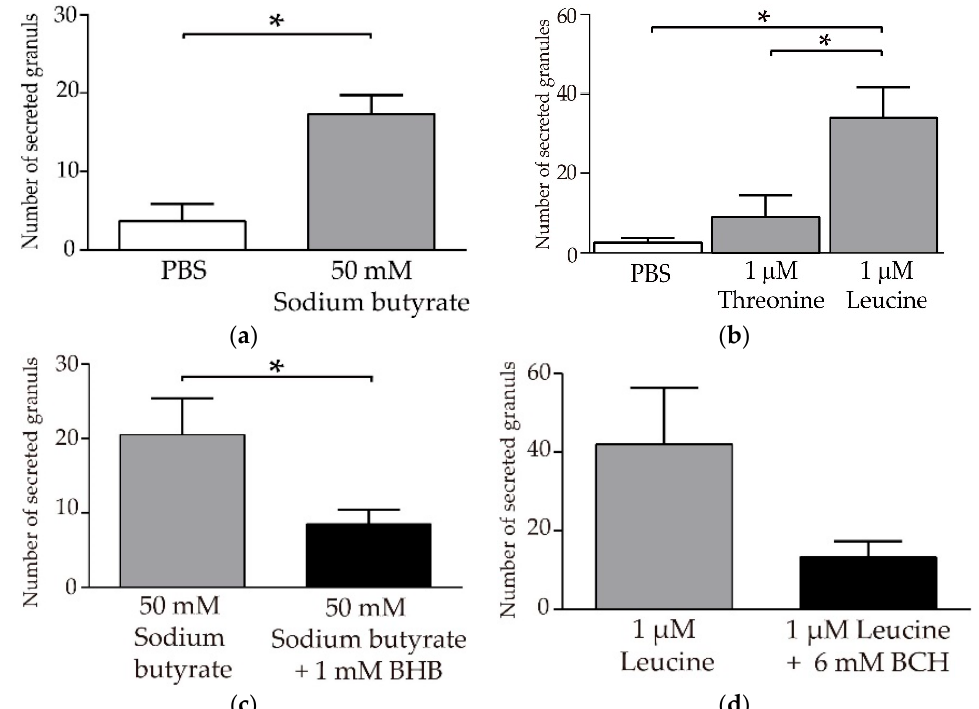
Figure 4. Quantification of secreted Paneth cell granules in response to butyric acid and leucine: ( a ) Enteroids at days 5 to 7 were injected with sodium butyrate (right bar, 17.3 ± 4.2) or PBS (left bar, 3.7 ± 3.8). Secreted granules were counted for 30 min after injection of reagents. Data are expressed as the total number of secreted granules from five Paneth cells ± SEM ( n = 3). * p < 0.05 by Student’s t -test. ( b ) Secreted granules after the introduction of L-threonine (middle bar, 9.0 ± 9.6) and L-leucine (right bar, 34.0 ± 13.1) were compared to that after PBS (left bar, 2.7 ± 2.1). Data are expressed as the total